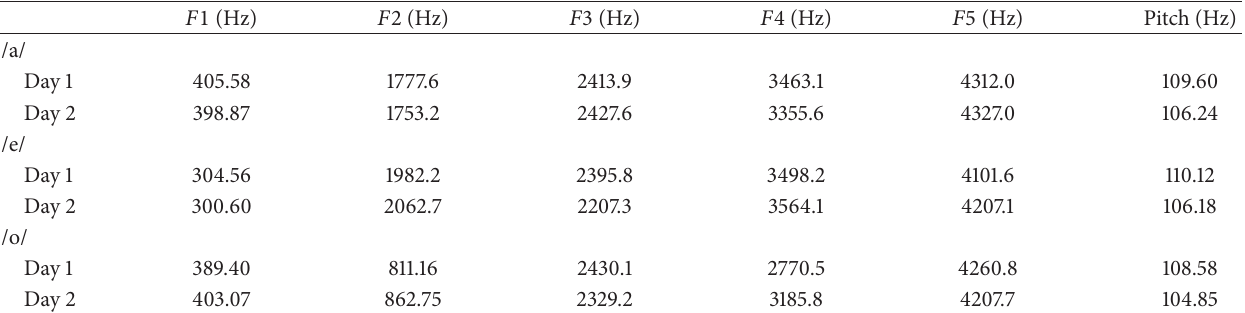
Table 5: Average formant frequencies and pitch for person 1 for both